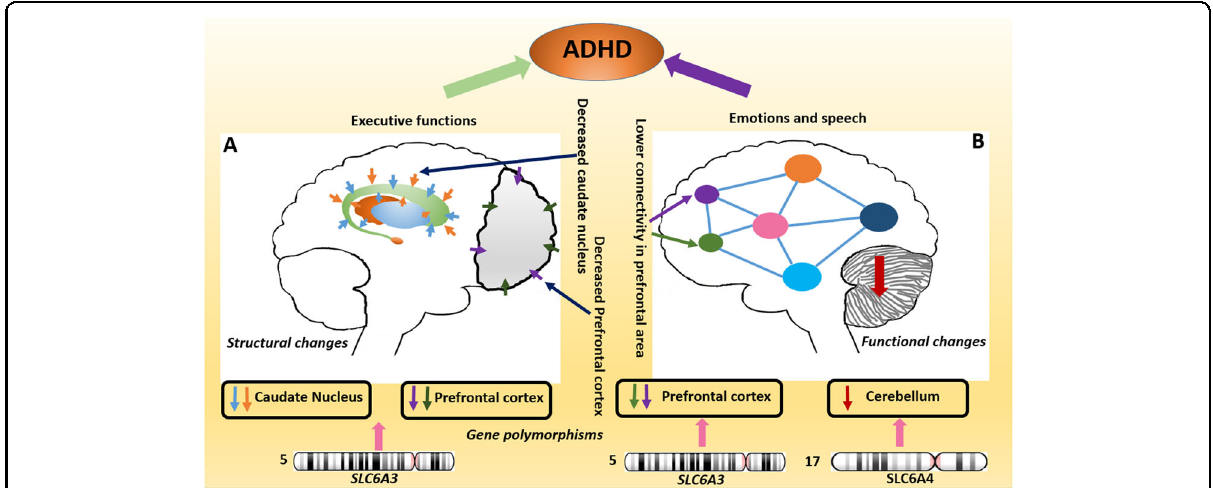
Fig. 8 The fi gure shows structural and functional brain changes associated with gene polymorphisms in patients with ADHD. A SLC6A3 polymorphisms are associated with lower caudate nucleus volume and prefrontal cortex in patients with ADHD. B SLC6A3 and SLC6A4 polymorphisms associated with lower functional activity in the prefrontal cortex and cerebellum in the brain of ADHD (Figure inspired from the manuscript by Tripp G, et al., 2009 188